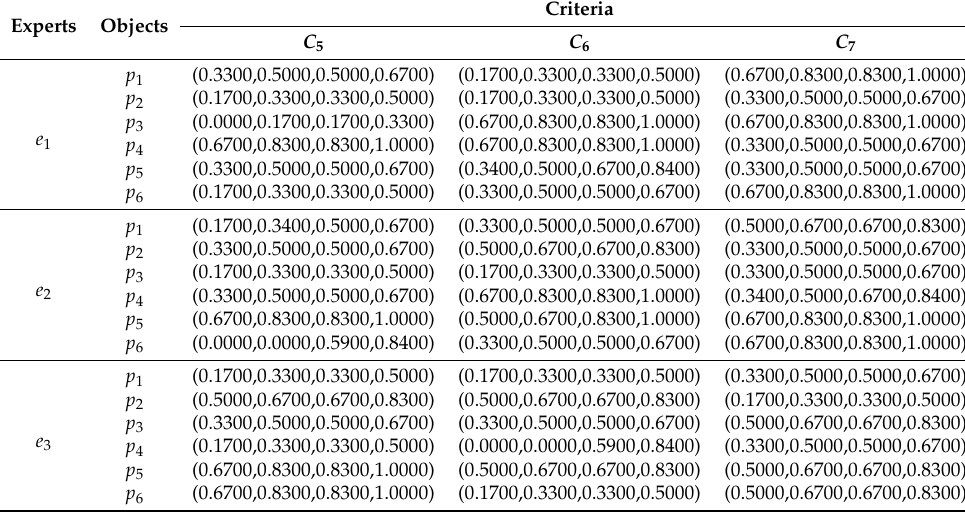
Table 7. Transformed information of ˜ X h -continued.